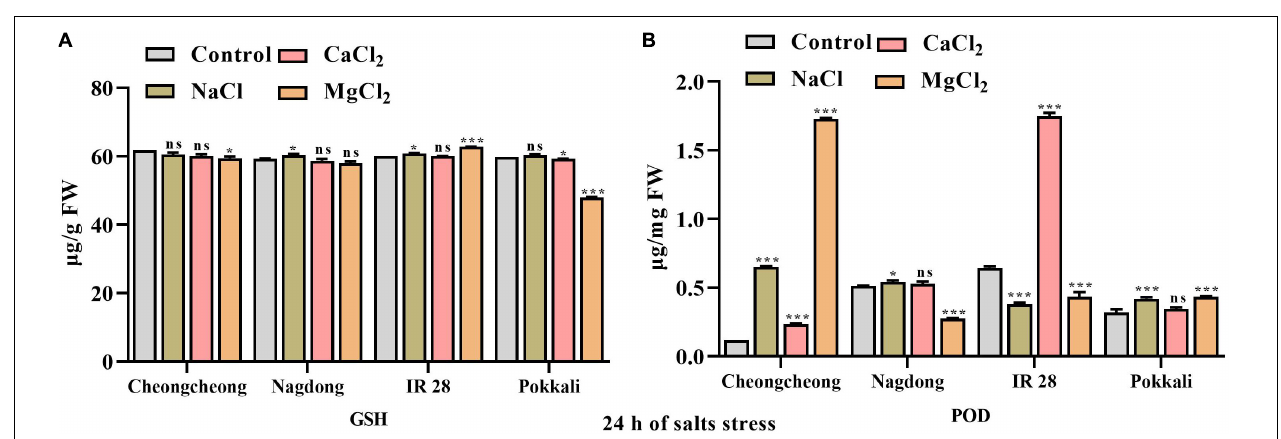
FIGURE 4 | Under 150 mM of different salt stress, quantitative real-time polymerase chain reaction expression analysis of OsHKT1 , OsNHX1 , and OsSOS1 relative to salinity in the roots and shoots of rice genotypes. The expression pattern in the heatmap (A–H) was determined in normalized gene expression (%) after 0, 6, and 12 h of salt stress.